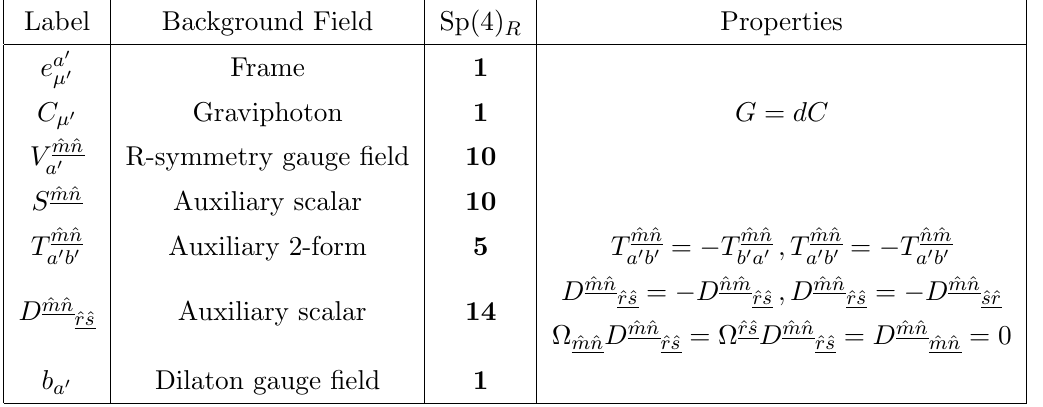
Table 1 . The bosonic background (cid:12)elds for 5d N = 2